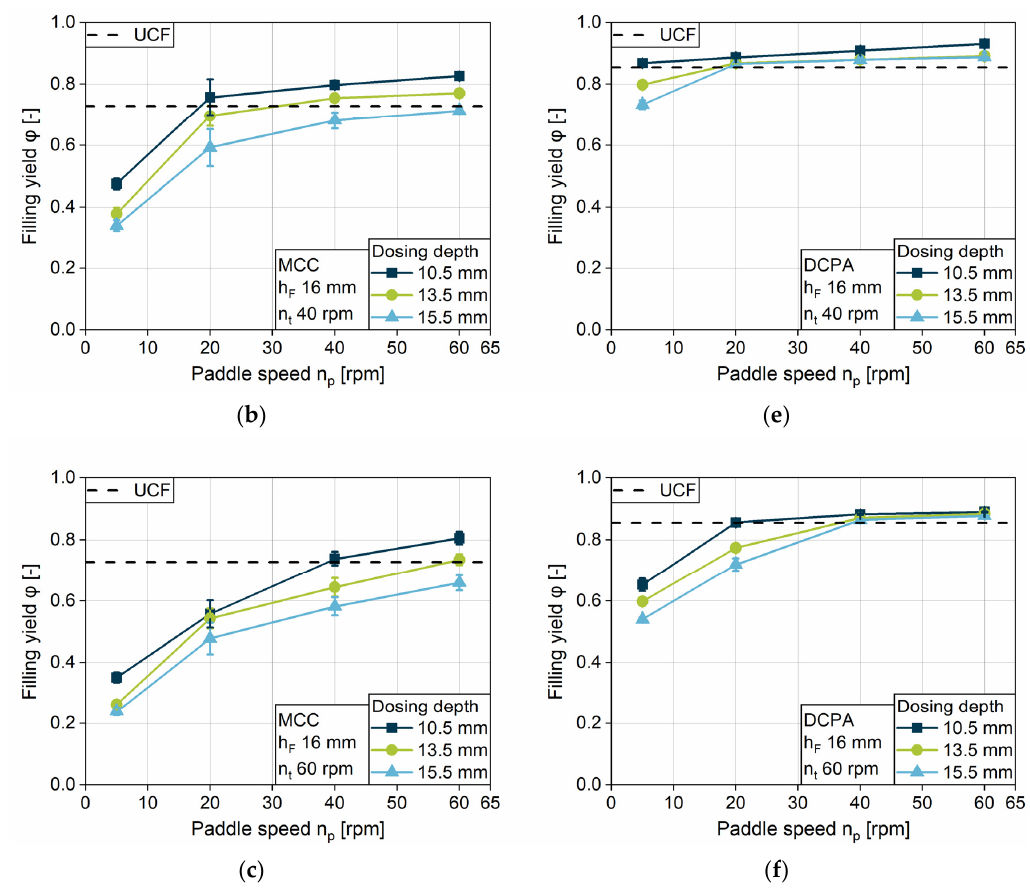
Figure 11. Filling yield for different dosing depth at a fill depth of 16 mm at 20, 40 and 60 rpm turret speed for MCC ( a , b , c ) and DCPA ( d , e , f ).